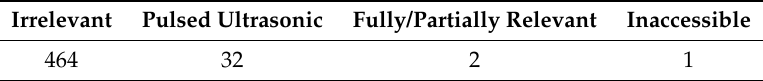
Table 1. Number of irrelevant, partially- or fully-relevant papers, as well as papers that display ultrasonic cure monitoring, but with a pulsed ultrasonic approach. The first 500 search results are sorted by relevance to the search terms “ultrasonic/ultrasound”, “cure”, “monitoring” and “resonant”.